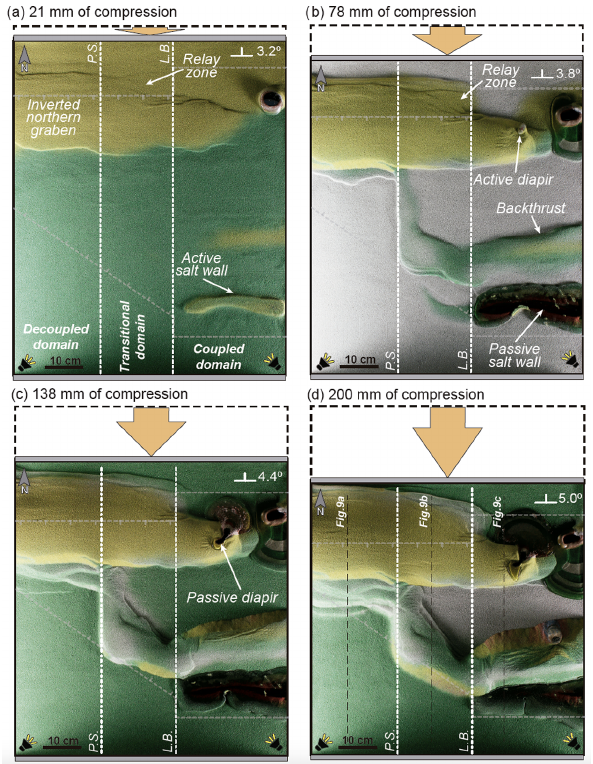
Figure 8. Overhead pictures showing the evolution of model 3. Il- lumination comes from the left. The position of the basement rigid blocks is shown in grey dotted lines, and the pinch-out of the poly- mer (P.S.) and the limit of basement blocks (L.B.) are shown in white dotted lines. (a) Overhead view after 21mm of shortening. (b) Overhead view after 78mm of shortening. (c) Overhead view after 138mm of shortening. (d) Overhead view at the end of the experiment (200mm shortening). Syn-orogenic sedimentation was performed during the compressional phase of this experiment by adding alternating green and white sand layers every